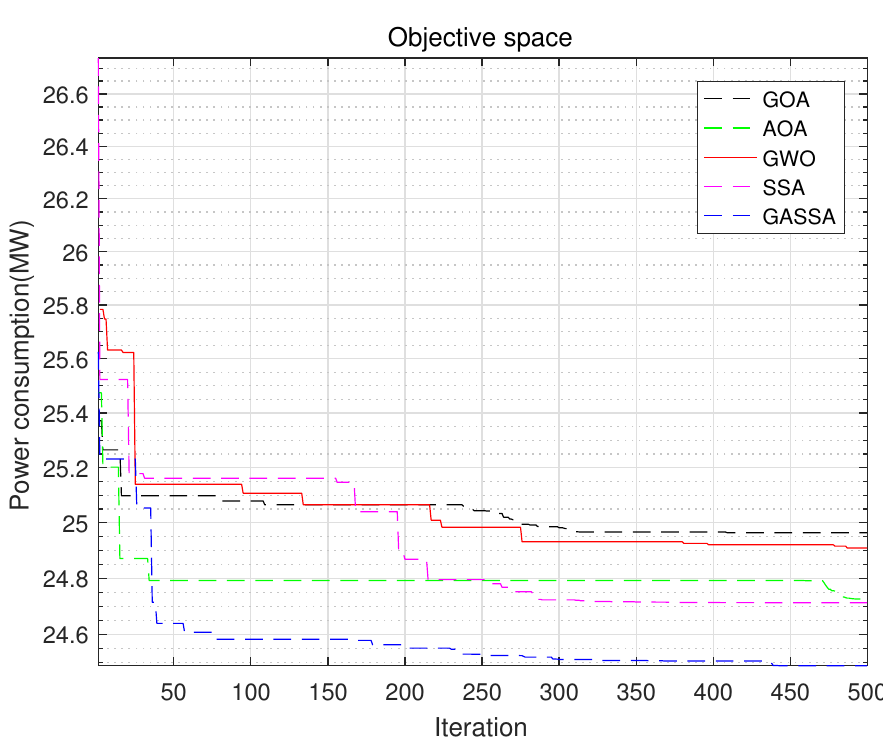
Figure 6. Comparison of 5 algorithms for optimizing